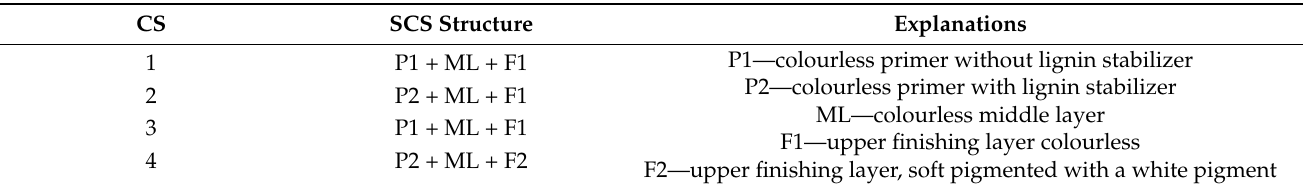
Table 1. Structure of coating systems applied on spruce wood.